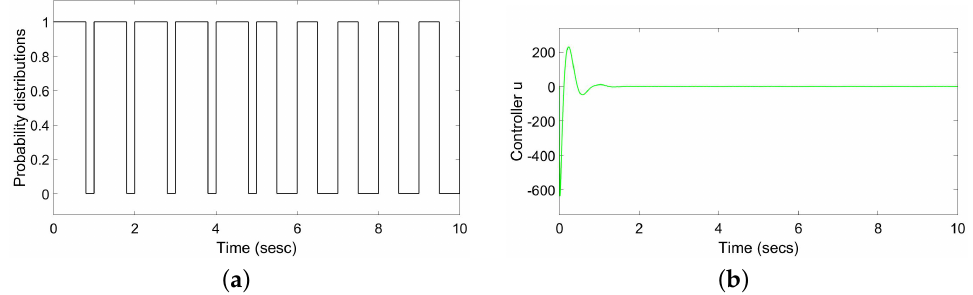
Figure 5. ( a ) Time-varying probability distribution; ( b ) controller u under probabilistic gain